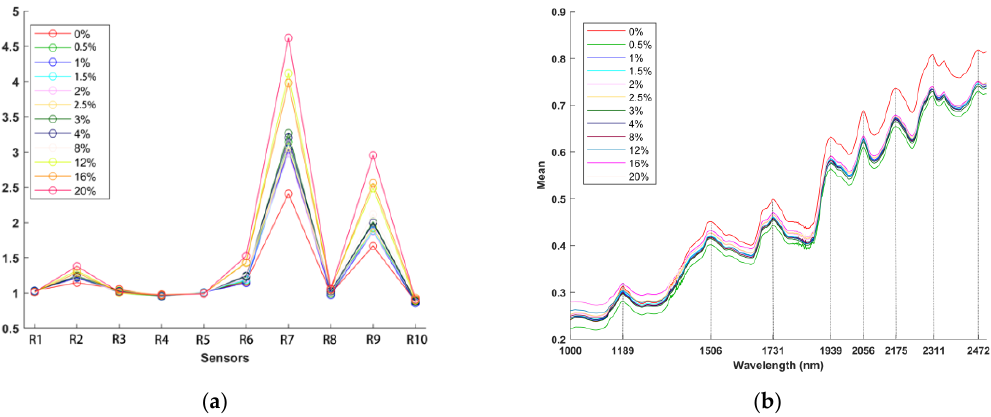
Figure 3. Plots of the mean data at different concentrations: ( a ) representative variation tendency of the electronic nose data; ( b ) representative variation tendency of the spectral data.